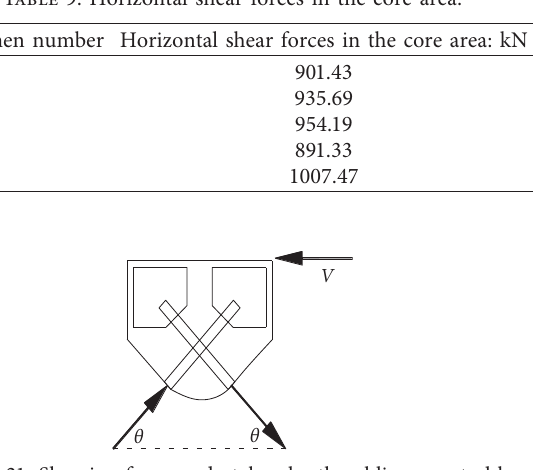
Figure 21: Shearing force undertaken by the oblique ventral